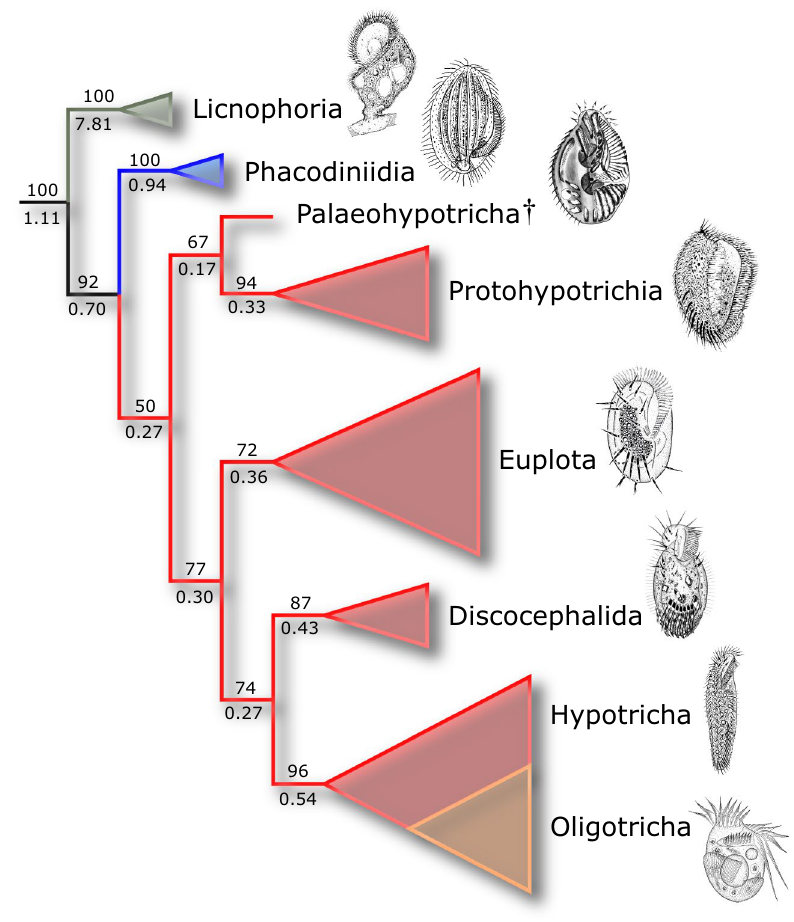
Figure 5. Simplified cladogram of the Spirotrichea showing resolution at higher taxa nodes, including the putatively extinct Palaeohypotricha nov. tax. Score ( k = 4.765625) 189.07802; consistency index (CI) = 0.44; retention index (RI) = 0.51. The hypotrichs s. l . branches are shaded in red. Numbers above and below branches are symmetric resampling GC frequencies and Bremmer support values, respectively. Branches without numbering are monotypic. Outgroup omitted. Illustrative figures from top to bottom (modified from original sources listed in Supplementary Table S1, Supplementary Materials): Licnophora lyngbycola (~ 150 µm); Phacodinium metchnikoffi (~ 100 µm); Palaeohypothrix bahiensis (~ 45 µm); Kiitricha marina (~ 100 µm); Euplotes aediculatus (~ 128 µm); Discocephalus ehrenbergi (~ 110 µm); Holosticha heterofoissneri (~ 141 µm); Propecingulum fistoleramalliei (~ 55